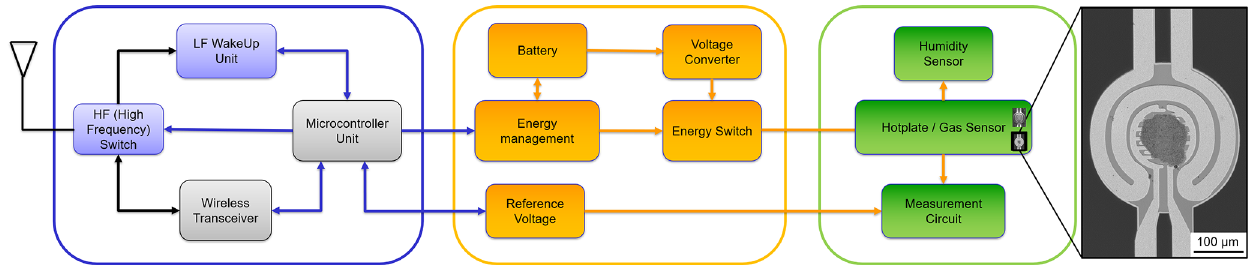
Figure 1. Detailed view of the measurement system. The radio module (blue part) manages the communication to the host, controls the energy management (orange part), and activates the sensor module (green part) if needed. The right image shows a magnified view of the sensor. The MEMS-based pellistor has a diameter of 320µm with a meandering platinum heater strip located at the outer area of the hotplate. The black dot in the centre of the hotplate represents the inkjet-deposited catalytic material.